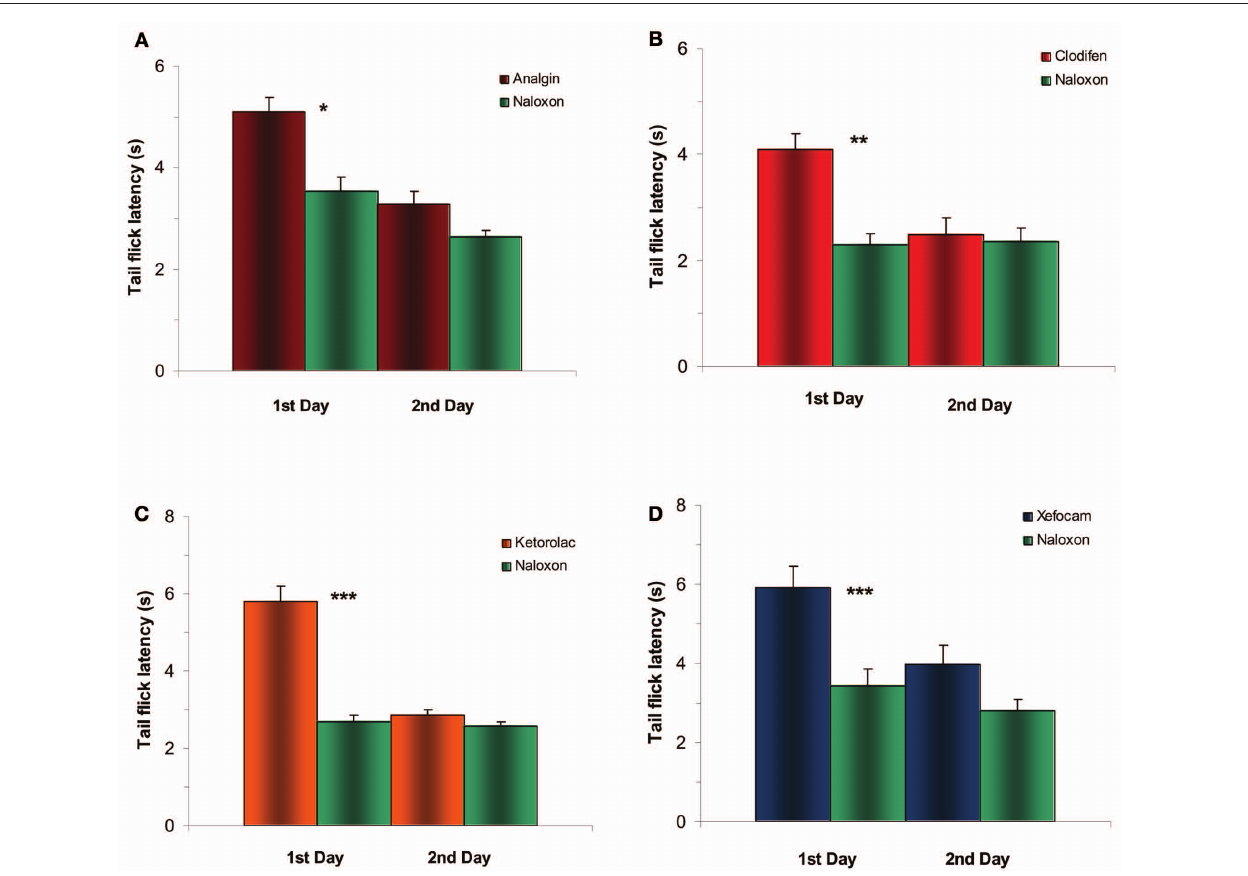
Figure 4 | experiments of post treatment with naloxone after microinjection of NSAiDs into NrM results in a significant decrease in TF latency for the first day for analgin (A), clodifen (B), ketorolac (C), and xefocam (D), respectively. On the second day, there are trend effects for all four non-opioid analgesics. N =4 per group. Here and in the next figure * P < 0.05, ** P < 0.01, *** P <